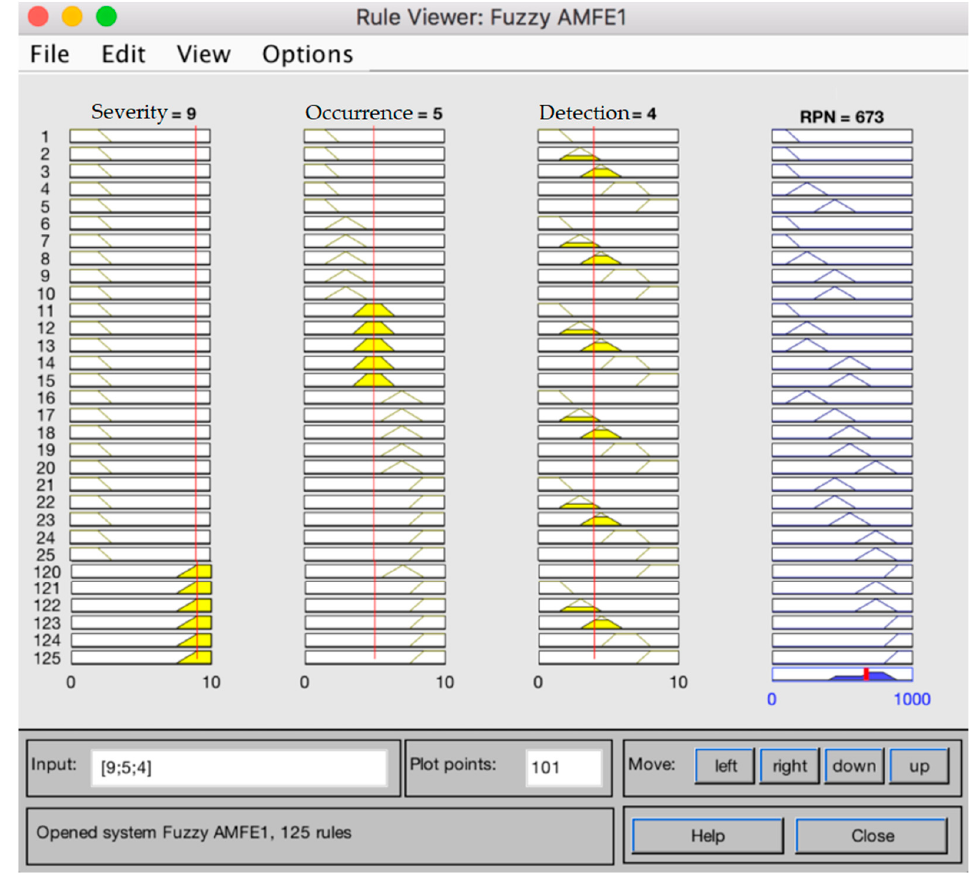
Table 8. Improvement measures for priority failure